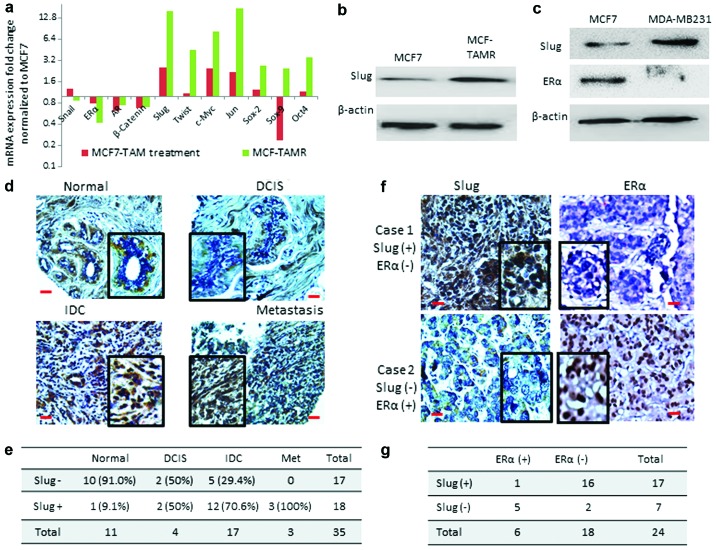
Slug correlated with breast cancer progression. (a) Transcription factor mRNA levels were compared by qRT-PCR in MCF7, MCF7 treated 5 days with 10−5 M tamoxifen and MCF-TAMR cell lines. GAPDH was used as a loading control. (b and c) Slug protein expression was analyzed by immunoblot in MCF7, MCF-TAMR and MDA-MB-231 lines. Cell extracts (50 μg) were loaded in each lane, and the membranes were probed with anti-ERα, Slug and β-actin antibodies to detect the respective proteins. (d) Representative examples of Slug protein expression (intensity) in breast cancer tissues from different patients and embedded on microarray (TMA) platform. Each sample was identified by H&E and tissue histologic/pathology classification. The top 2 samples (normal and ductal carcinoma in situ) show Slug negative expression in luminal cell nucleus and the bottom 2 samples (invasive ductal carcinoma and metastasis) show Slug positive expression in cell nucleus. Scale bars, 50 μm. (e) IHC assessment of breast cancer cell nuclear Slug expression from TMA was based on the histologic cellular classification (28 patients 35 cores). (f) Representative examples of Slug and ERα protein expression in breast cancer tissue microarray (TMA). Case 1 shows an example of Slug-positive ERα-negative finding. Case 2 shows an example of Slug-negative ERα-positive finding. Scale bars, 50 μm. (g) IHC assessment of breast cancer ERα and Slug protein expression from breast cancer TMA (21 cancer patients 24 cancer cores).